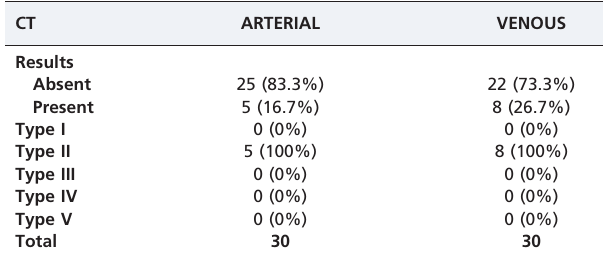
Table 1 - Endoleaks from the arterial and venous phases. CT ARTERIAL VENOUS Results Absent